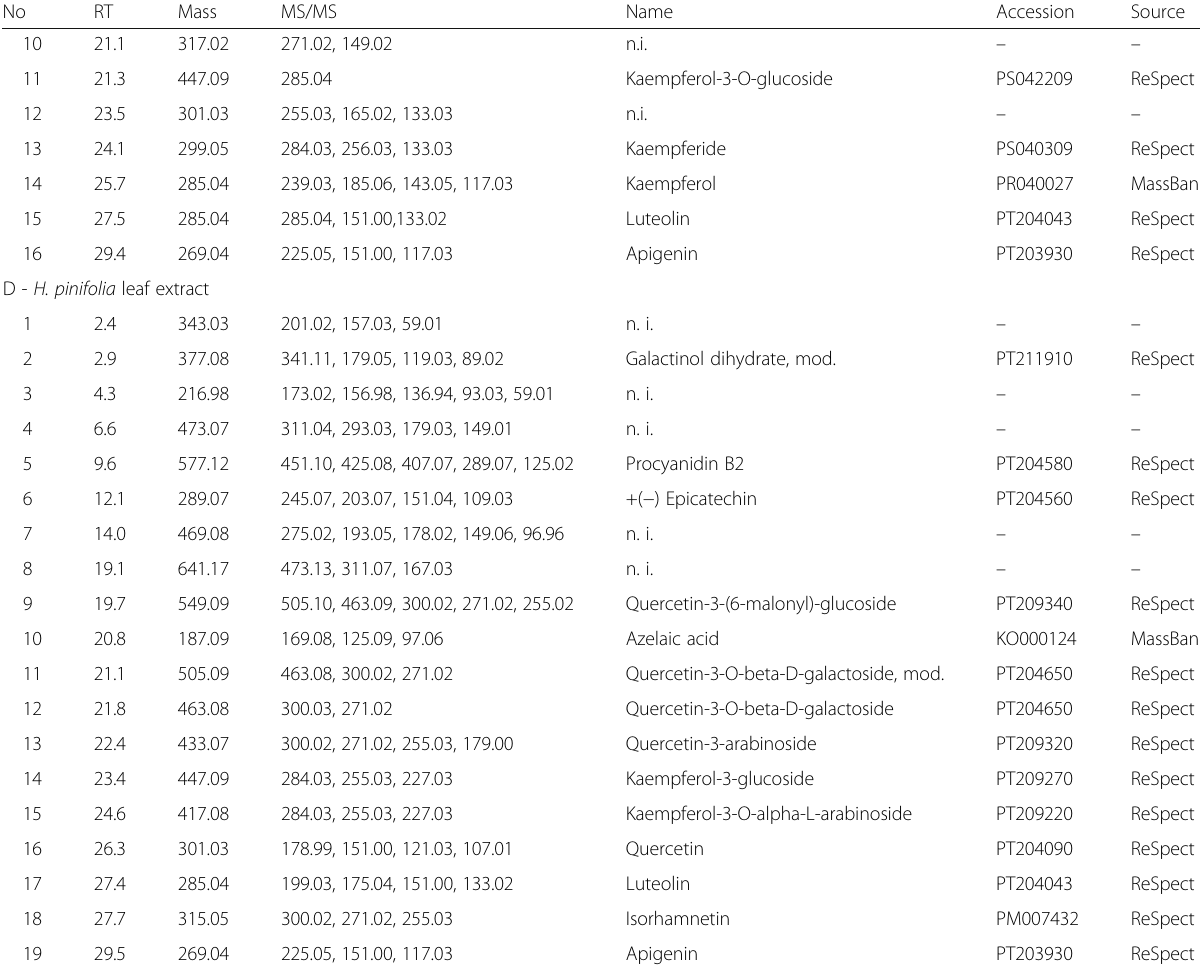
Table 2 Individual compounds identified by comparison of MS/MS spectra with database entries in Enhalus acoroides leaf extract (A), E. acoroides root extract (B), Halophila ovalis leaf extract (C) and Halodule pinifolia leaf extract (D)